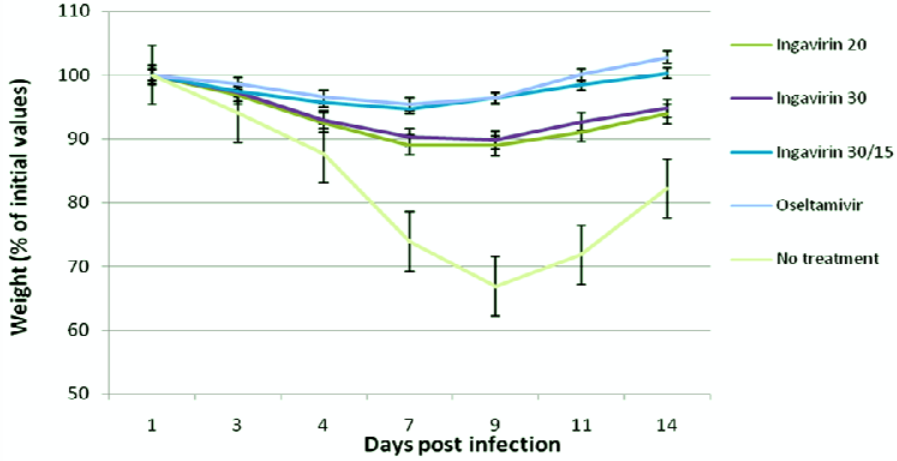
Figure 2. Dynamics of body weight of mice in the course of pneumonia caused by influenza virus A/California/7/09